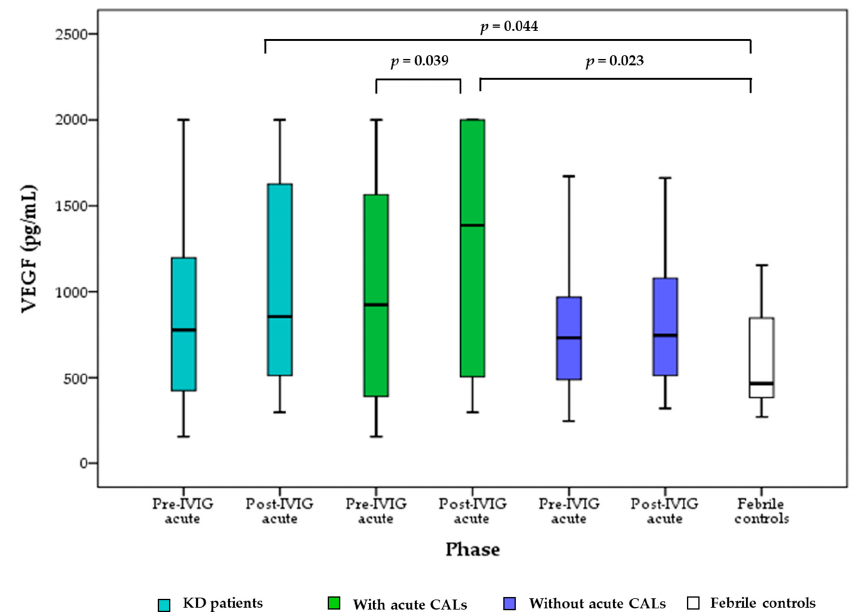
Figure 1. Comparisons of vascular endothelial growth factor (VEGF) levels between KD patients with/without acute CALs in acute phase and febrile controls. Central box, values from the lower to upper quartile (25th–75th percentile). In the box plots, the middle line represents the median. The p -value was estimated by the Wilcoxon sign-rank test in KD patients in different phases. The p -value was estimated by the Mann–Whitney U test between KD patients and febrile controls.